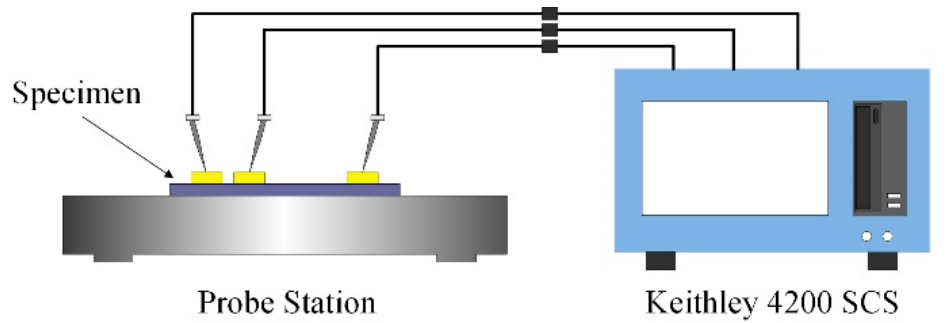
Figure 8. Schematic diagram of the experiment equipment.